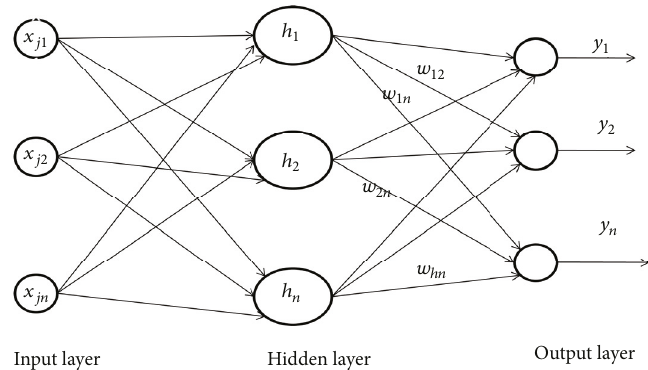
Figure 2: RBF neural network